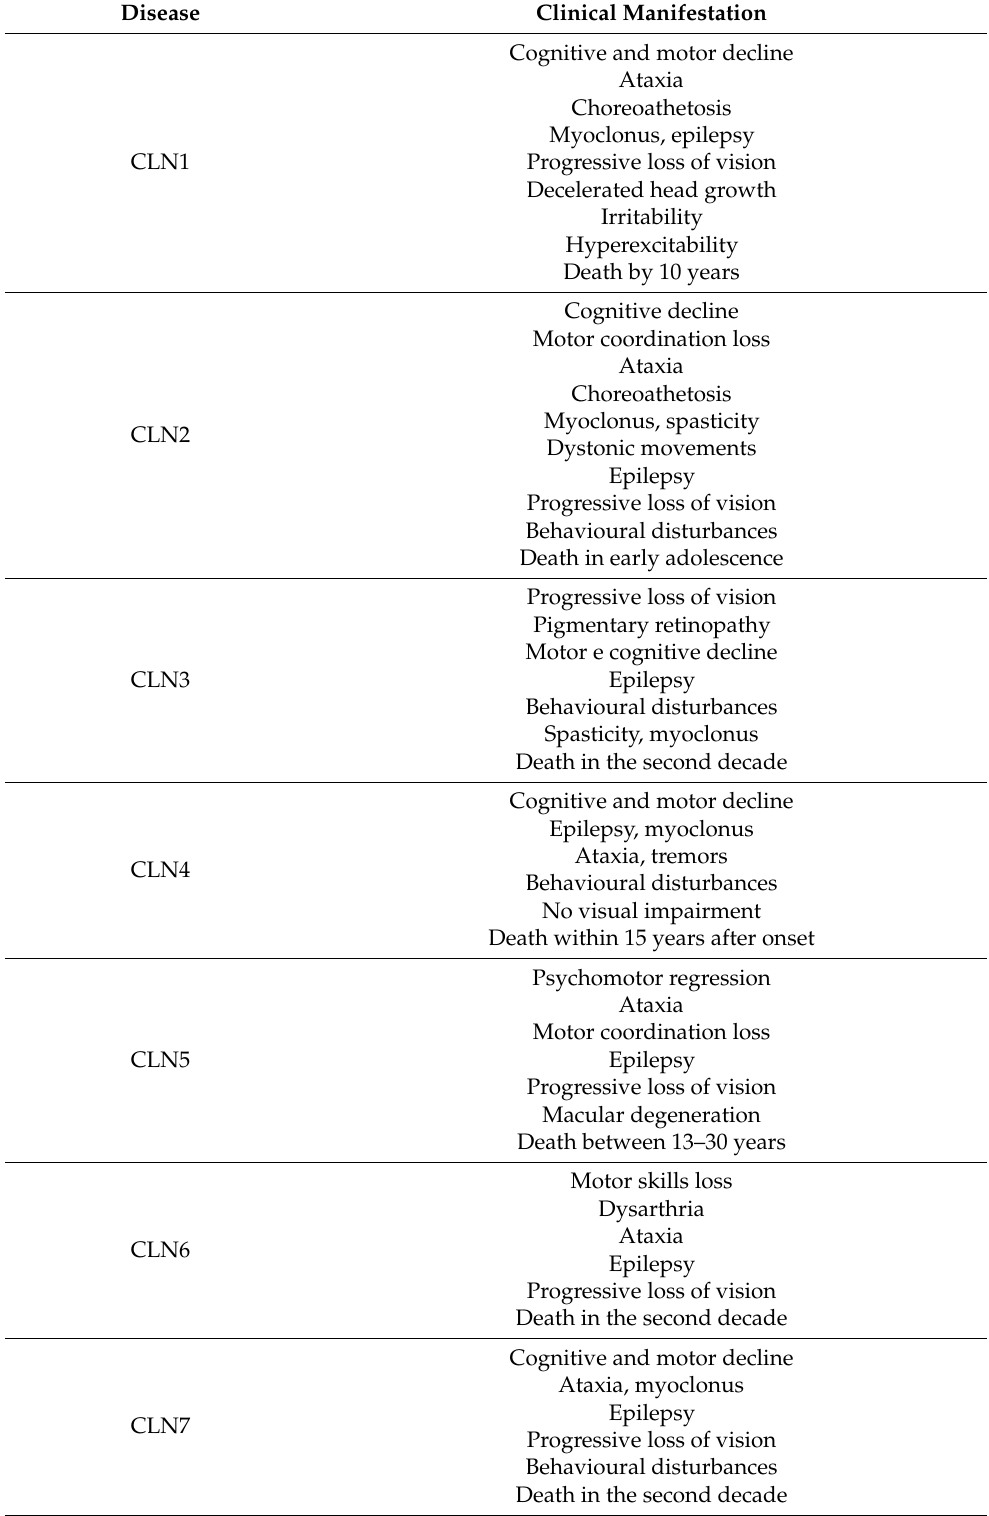
Table 3. Major clinical manifestations